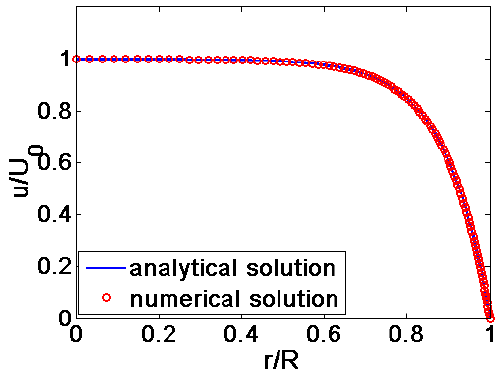
Figure 2. The comparison of the analytical solution with the numerical solution ( n = 1 and ξ = − 1).